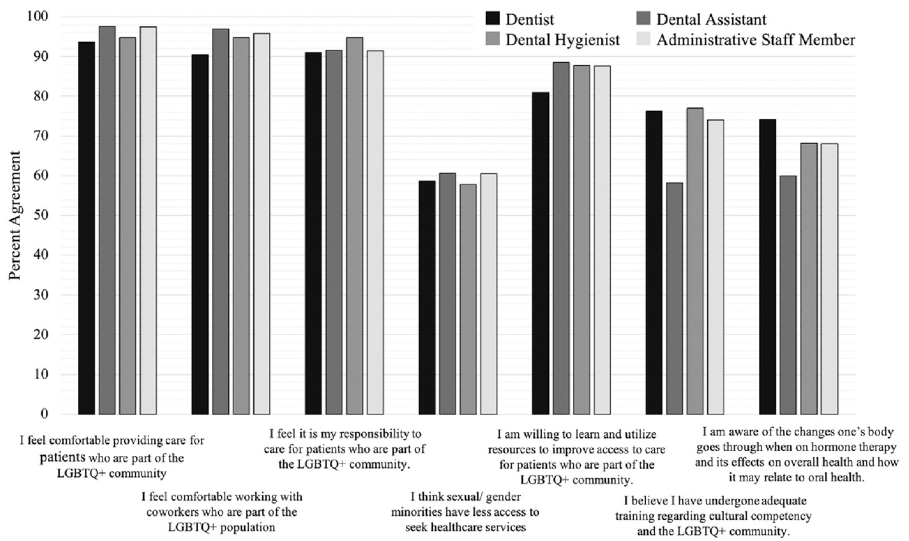
Fig 1. Provider beliefs and attitudes toward members of the LGBTQ+